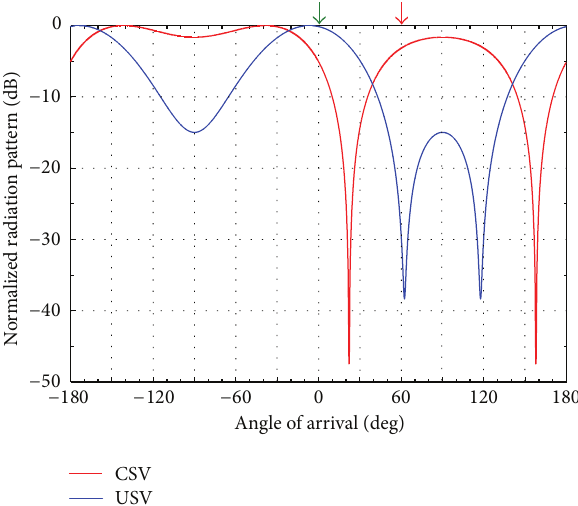
Figure 3: Synthesized pattern of a 2-element dipole array. Desired signal (green arrow): 0 ∘ , 40dB; 1 jammer (red arrow): 60 ∘ ,